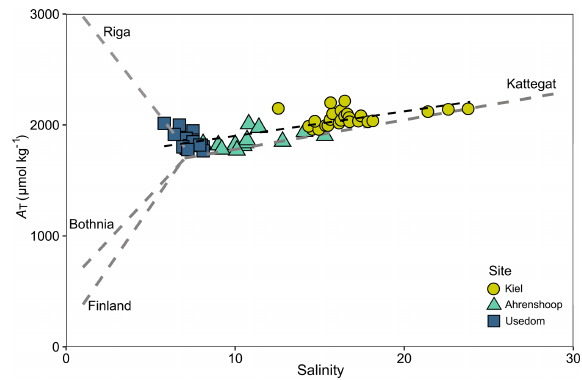
Figure 4. A T – S relationship from field monitoring data over the monitoring period for each site showing a linear fit with model pa- rameters given in Table S7. Linear A T – S relationships (grey dashed lines) for the Gulf of Bothnia, Gulf of Finland and the Kattegat are also depicted, using 2D linear model parameters for 2014 from Müller et al. (2016). The linear A T – S relationship for the Gulf of Riga is shown using model parameters for 2008 from Beldowski et al. (2010).